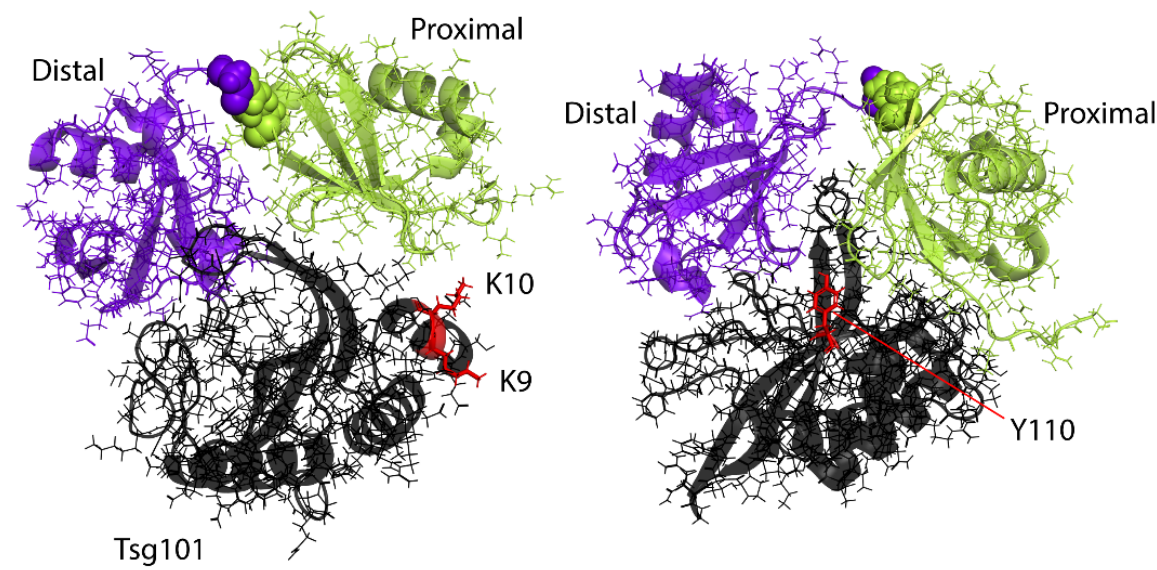
Figure 5. Binding modes of Lys63-linked di-Ub on the Tsg101 UEV domain. ( Left ), Di-Ub complex with proximal domain in contact with N-terminal region; ( Right ), Di-Ub complex with proximal domain in contact with vestigial active site. Key determinants of recognition of the two binding modes (proximal-1, K9, K10; proximal-2, Y110, respectively) are highlighted in red sticks. PDB ID: 6UD0.